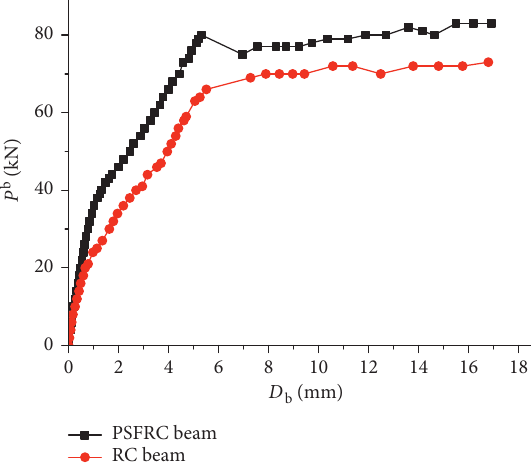
Figure 13: Lot of load versus